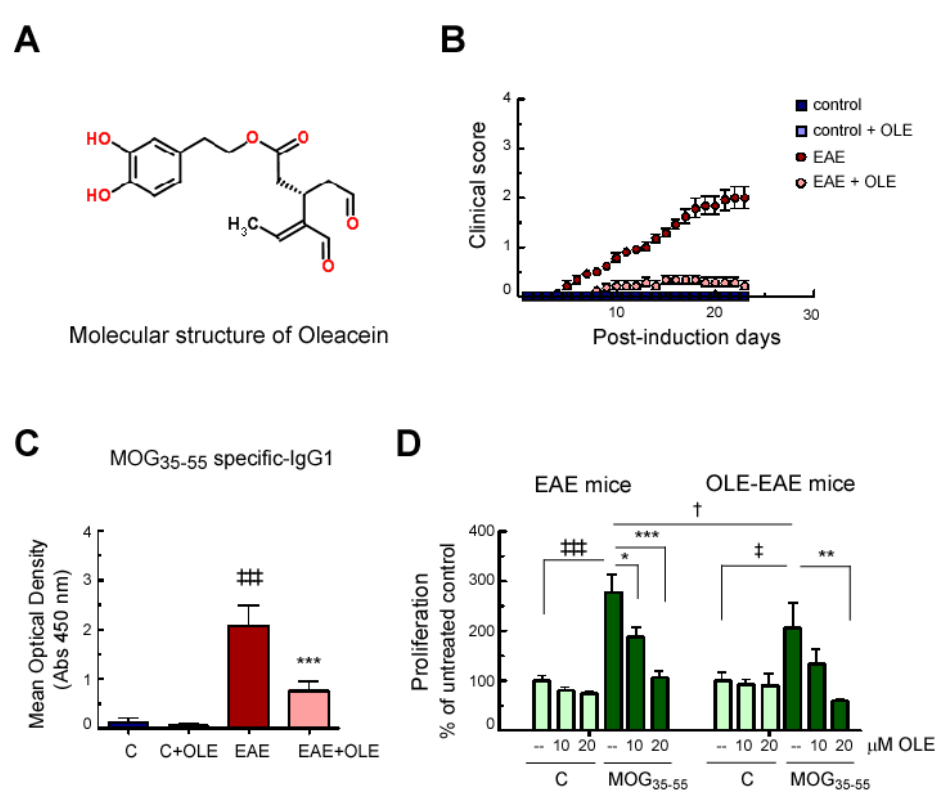
Figure 1. Oleacein (OLE) treatment protects mice from experimental autoimmune encephalomyelitis (EAE). ( A ) Chemical structure of Oleacein. ( B ) Clinical scores of EAE in mice treated with 10 mg/kg/day of OLE. The error bars represent the SEM for each point. Depicted are the combined results of two independent experiments ( n = 9 in control and OLE-control groups; n = 11 in EAE and OLE-EAE groups) ( C ) Titers of MOG 35–55- specific IgG1 in serum samples at 1/60 dilution. ‡‡‡ p < 0.001 vs. control and *** p < 0.001 vs. EAE. ( D ) Effect of OLE on splenocyte cell functions. In vitro, MOG 35–55 -specific proliferative response of splenic cells from EAE mice and OLE-treated EAE mice. T cell proliferation was measured in spleen lymphocyte cultures incubated for 72 h in the presence or absence of MOG 35–55 and with or without the indicated dose of OLE. Spleen lymphocytes were obtained at day 24 after EAE induction. Histograms represent the mean ± SEM. Measures were performed in duplicated wells, n = 5 in each group, from two independent experiments. ‡‡‡ p < 0.001 and ‡ p < 0.05 vs. control; *** p < 0.001, ** p < 0.01 and * p < 0.05 vs. MOG 35–55 without OLE; † p < 0.05 vs. EAE mice.